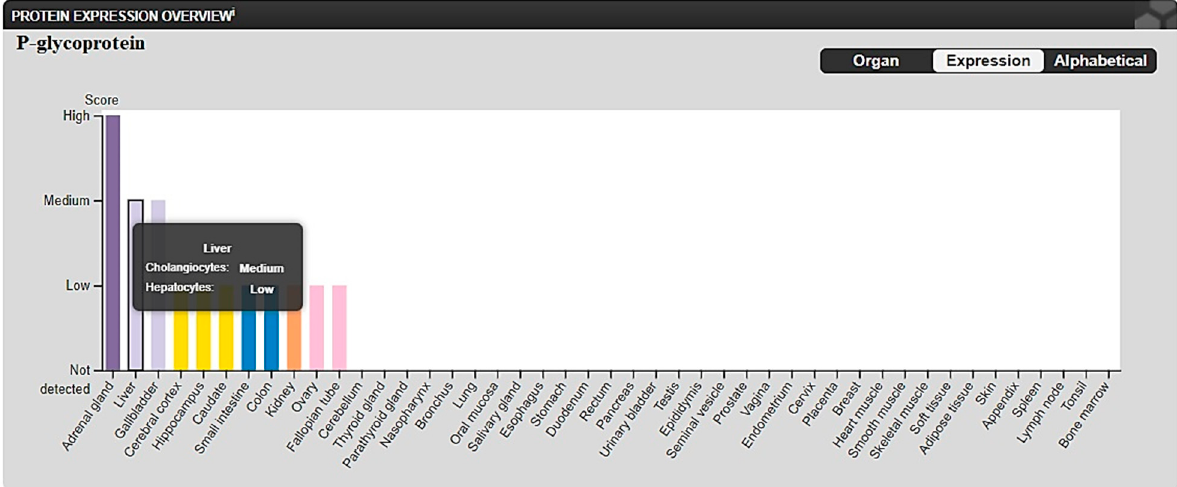
Figure 16. P-glycoprotein expression in different tissues.